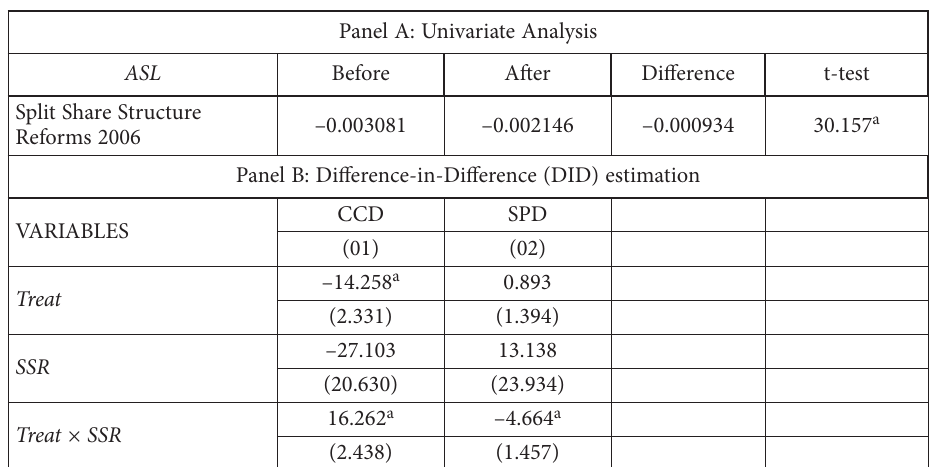
Table 6. Endogeneity